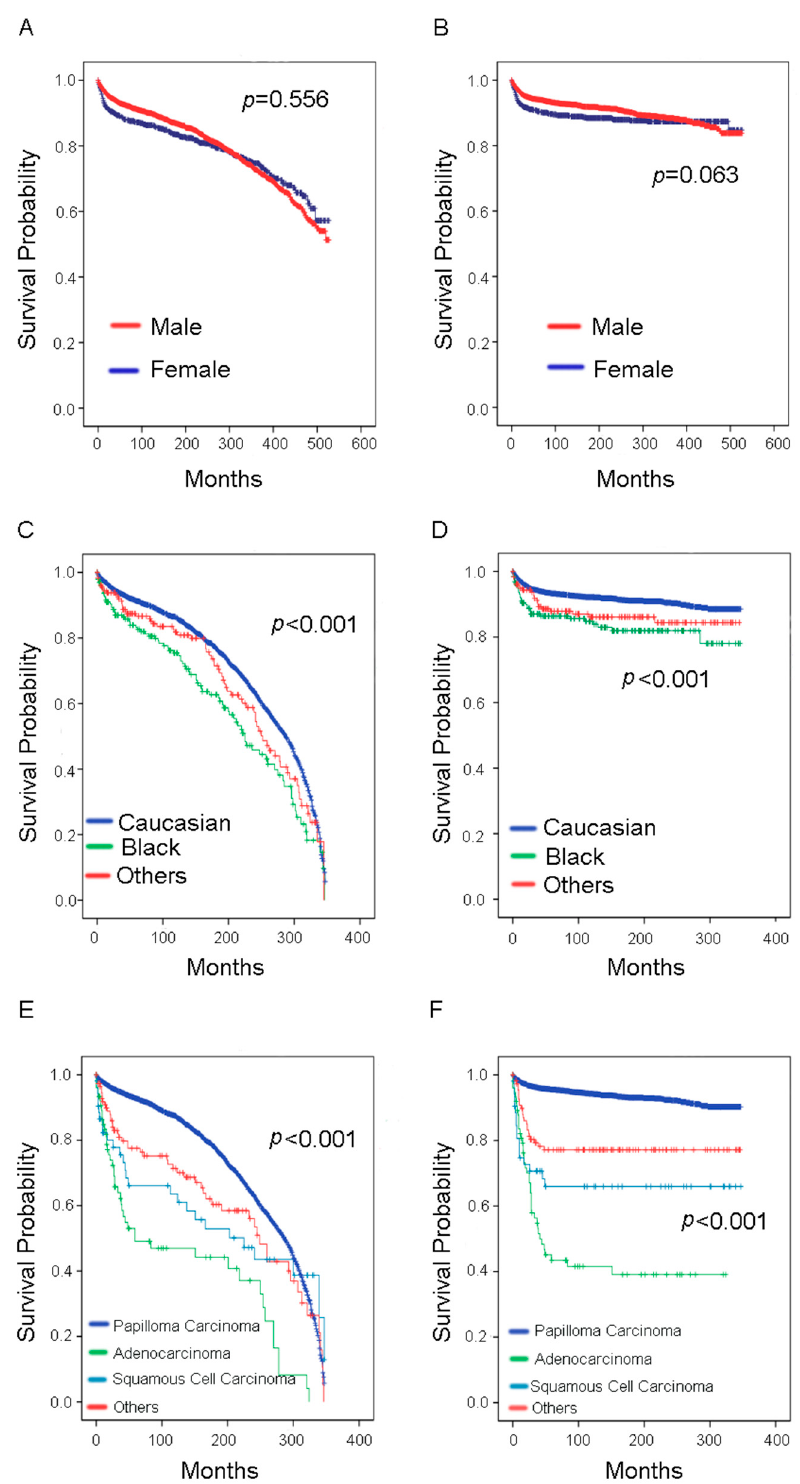
Figure 3. Survival analysis in younger bladder cancer patients with gender ( A ) OS, ( B ) CSS, race ( C ) OS, ( D ): CSS, and histological type ( E ) OS, ( F ) CSS. OS = overall survival; CSS = cancer-specific survival.